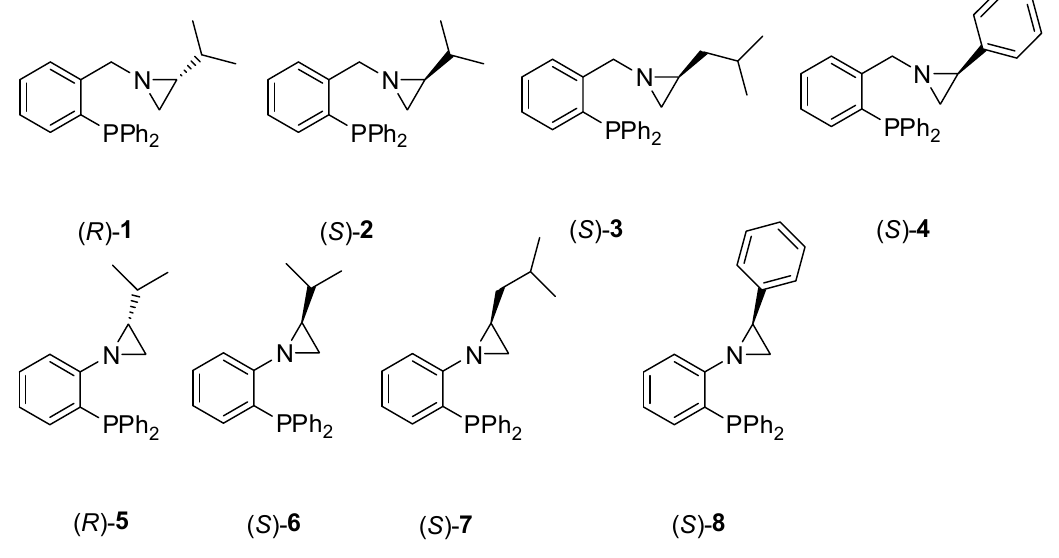
Figure 1. Chiral aziridine-phosphines 1–8 .